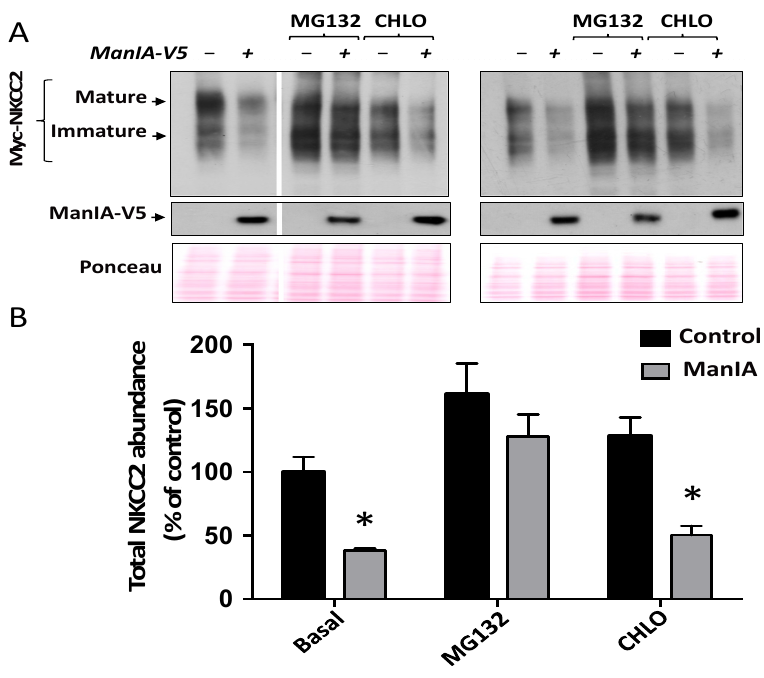
Figure 6. ManIA decreases NKCC2 expression in a proteasome-dependent manner. ( A) Effect of MG132 and chloroquine on ManIA-induced down-regulation of NKCC2. 18 h post-transfection with NKCC2 and ManIA constructs, HEK cells were treated with or without 10 μ M MG132 or 100 μ M chloroquine for 6 h prior to cell lysis as previously [53,61] .The cell lysates were subjected to immunoblotting with anti-Myc and anti-V5 antibodies. ( B ) Densitometric analysis of NKCC2 bands from untreated and treated cells with MG132 or chloroquine (CHLO). Data are expressed as percentage of control ±S.E. * p < 0.008 versus control ( n = 3).